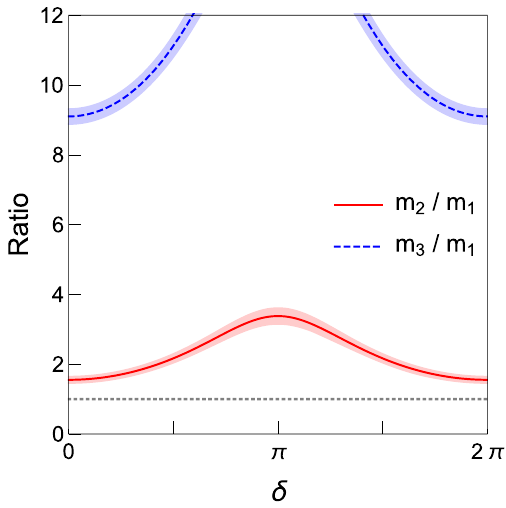
Fig. 1 The mass ratios m 2 / m 1 and m 3 / m 1 as functions of the Dirac CP phase δ in the minimal gauged U(1) B + L model with a e − 3 L μ − L τ singlet scalar. The bands show uncertainty coming from the 1 σ error in θ 12 , which gives dominant contributions. The thin gray dotted line corresponds to m 2 , 3 / m 1 = 1. For input parameters of the neutrino mixing angles, we use the NO values in Table